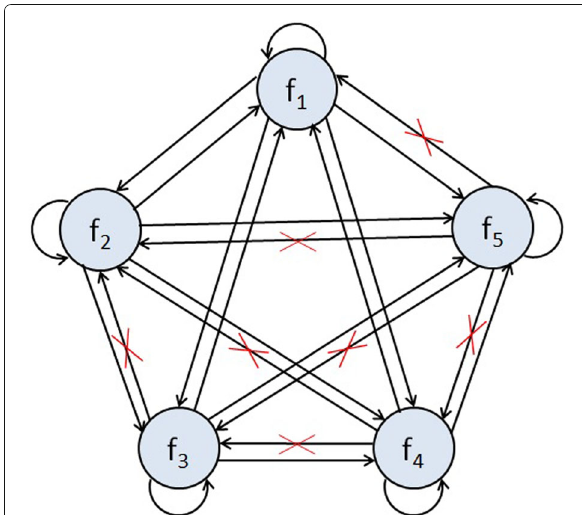
Fig. 5 Schematic diagram showing fingering transfer path when T is added